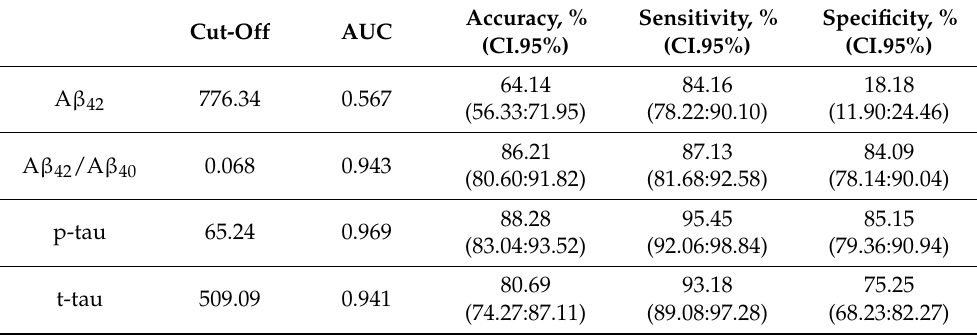
Table 2. CSF biomarker accuracy .